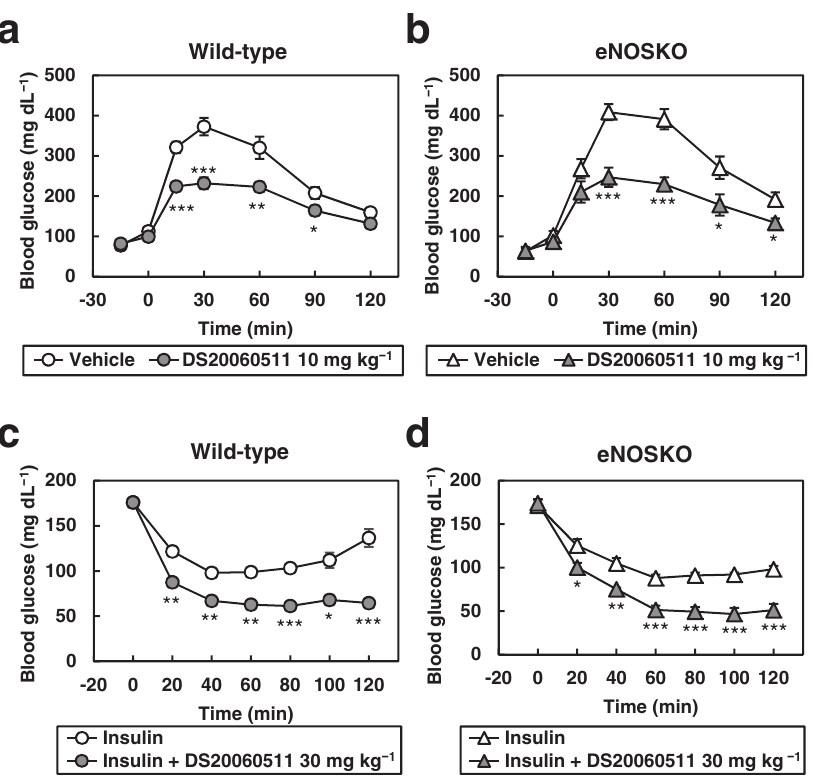
Fig. 7 DS20060511 treatment decreases blood glucose levels in both WT and eNOSKO mice during oral GTT and ITT. a , b Blood glucose levels during oral GTT in wild-type (WT, n = 5) and eNOS-knockout (KO, n = 5 – 6) mice. Mice received vehicle or DS20060511 (10 mg kg − 1 ) orally 15 min before the glucose administration (3.0 g kg − 1 ). c , d Blood glucose levels during ITT in WT ( n = 4) and KO ( n = 5) mice. Vehicle or DS20060511 (30 mg kg − 1 ) was given orally at the same time as 0.5 U kg − 1 insulin injection intraperitoneally. Values shown are means ± SEM. * P < 0.05, ** P < 0.01, *** P < 0.001 vs. vehicle by the t